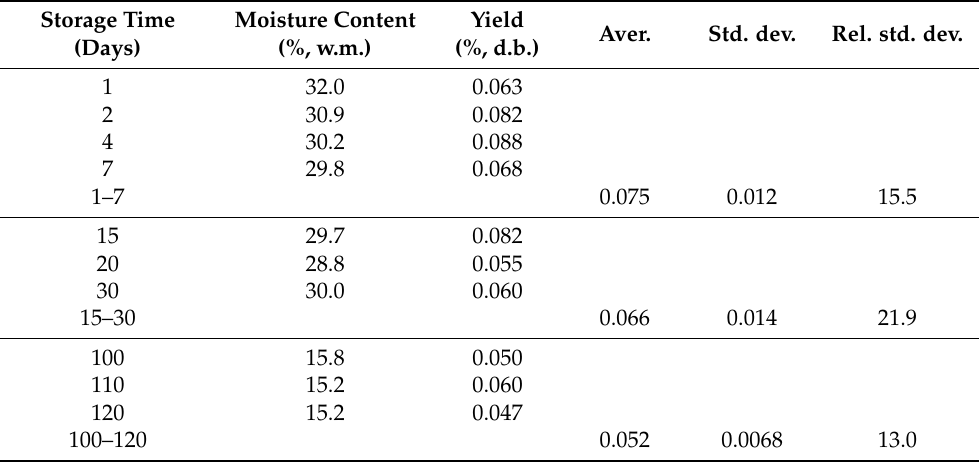
Table 1. Essential oil yields obtained in the batch steam distillations with stored Cistus ladanifer . Storage Time Moisture Content Yield Aver. Std. dev. Rel. std. (Days) (%, w.m.) (%, d.b.)